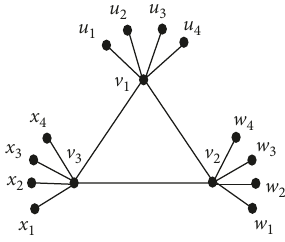
Figure 2: A representation of corona product K